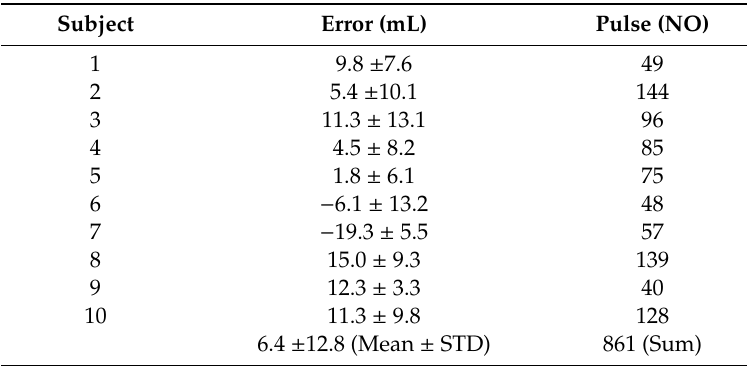
Table 3. The statistic error of SVs between the medis ® CS200 device and our ICG device using the PPG pulses with high SQI.